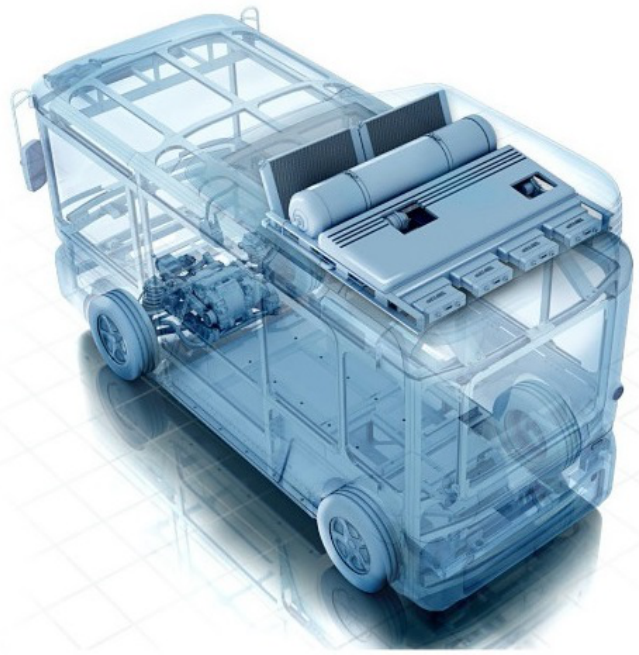
Figure 1. Sketch of a zero-emission light commercial vehicle with a fuel cell range extender mounted on the roof [21], reproduced with permission from e.GO REX